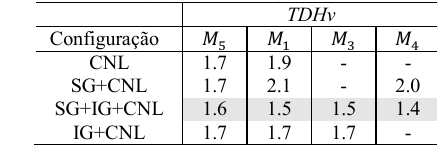
Table V. Values of THDi (%) in 𝑀 1 ,𝑀 2 ,𝑀 3 𝑒 𝑀 4 with 𝑁 𝐿 .